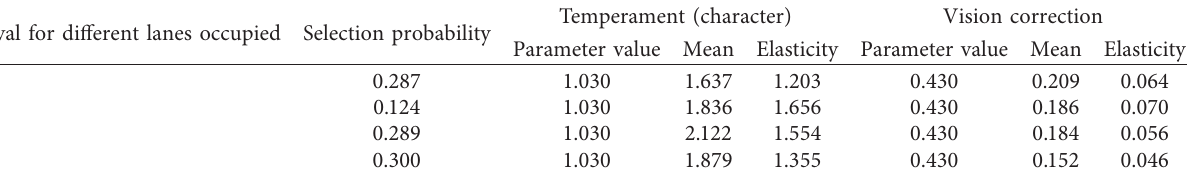
Table 11: Calculation results on temperament and eye